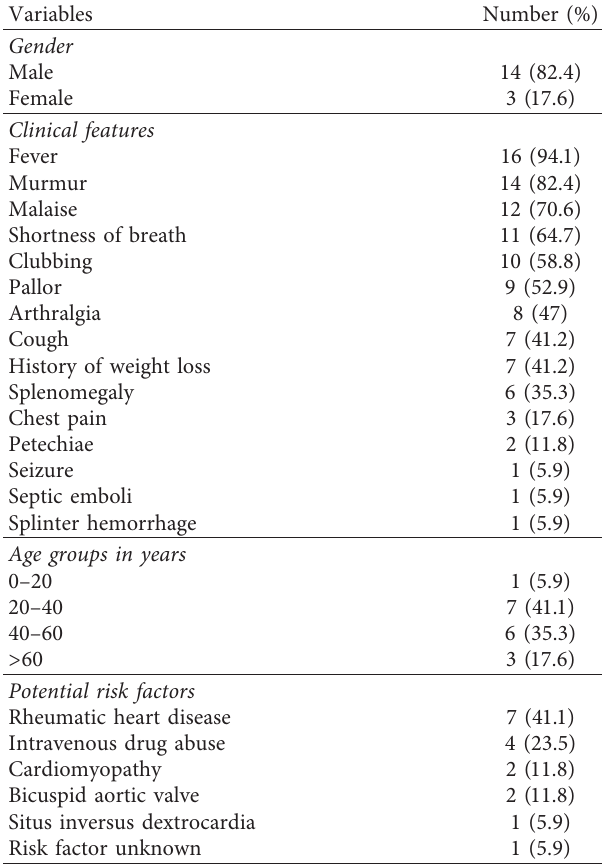
Table 1: Summary of clinical profiles of IE patients ( n � 17).